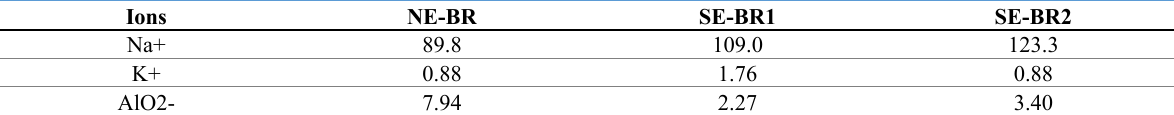
Table 3 S oluble ions quantified mixing 10g of residue in 100ml of deionized water. Results are presented in mmol/kg of BR.